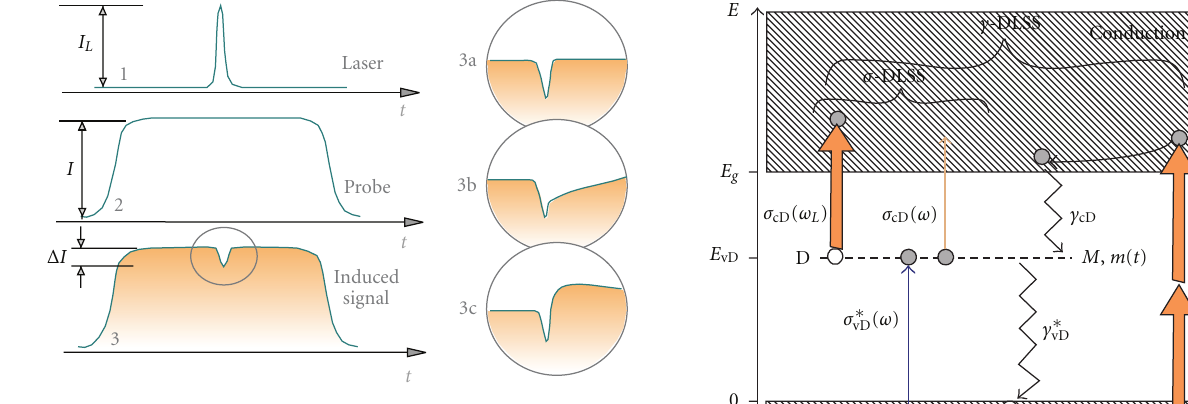
Figure 2: Scheme of the typical for DLSS experiment signals: short modulating laser light pulse (1), long probe light pulse (2), and resulting induced absorption signal (3) after crystal transfer. Insets (3a)–(3c) show detailed signals of di ff erent nature: coherent inertialess two-photon absorption (3a), combinations of TPA, and laser modulation of incoherent two-step absorption (induced absorption (3b) and bleaching (3c)).